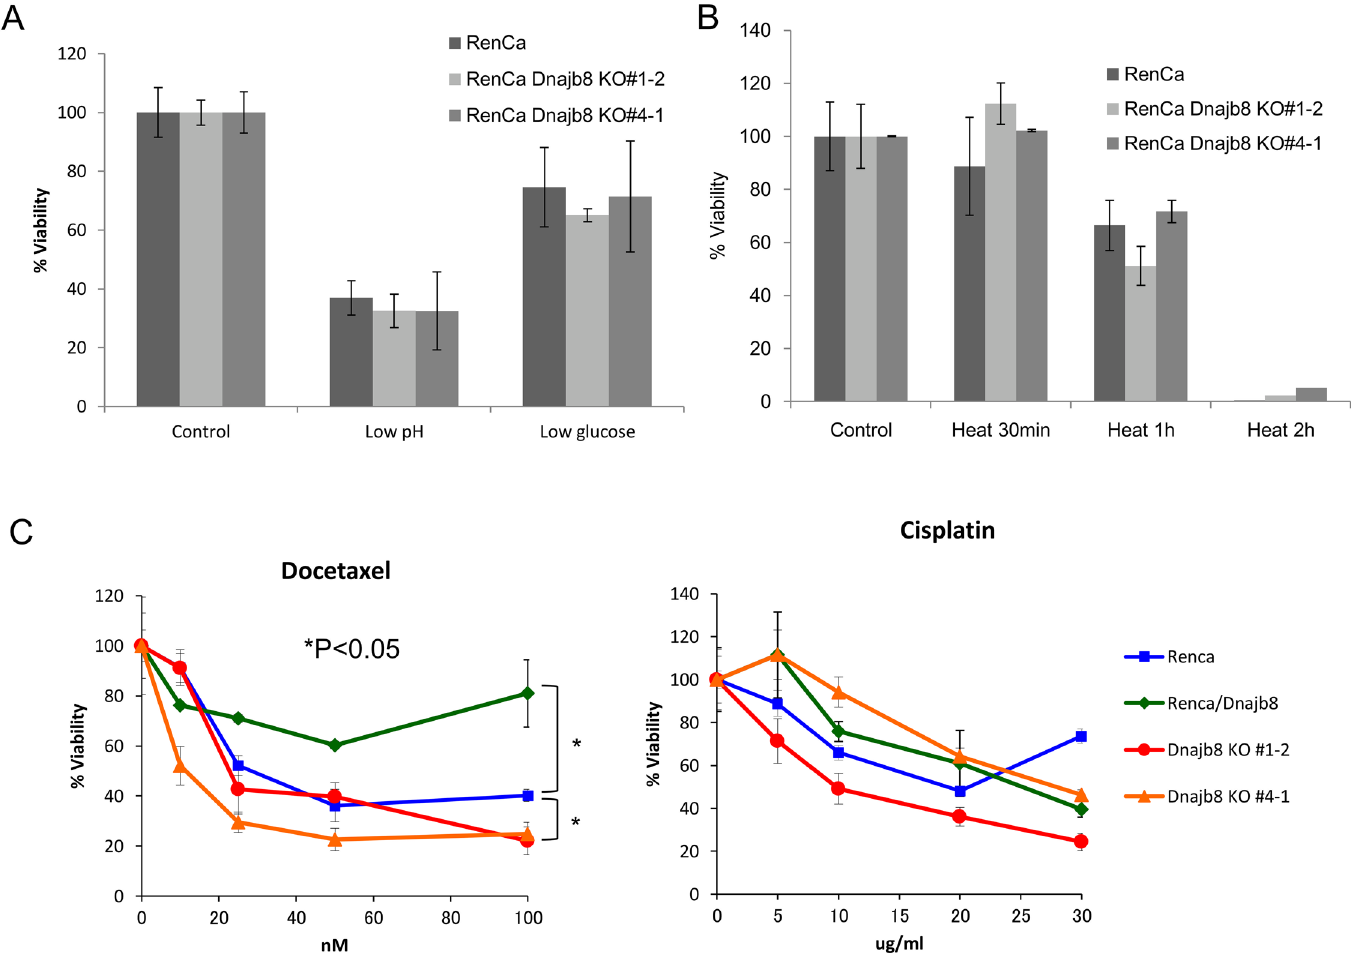
Fig 4. Analysis of stress response. (A) Low pH stress and low glucose stress. Ten thousand cells were cultured for 5 days and the number of cells was counted. Data represent the percent of alive cell rates compared with control groups. (B) Responses to heat shock stresses. Ten thousand cells were cultured for 5 days after heat shock stress, and the number of cells was counted. Data represent the percent of alive cell rates compared with control groups. (C) Chemo-resistance. Eight thousand cells were cultured for 4 days in chemotherapeutic reagents (Docetaxel or Cisplatin). The percentage of viability were addressed using WST-8 reagents. Data are shown as means ± SD. Differences between groups were examined for statistical significance by Student's t-